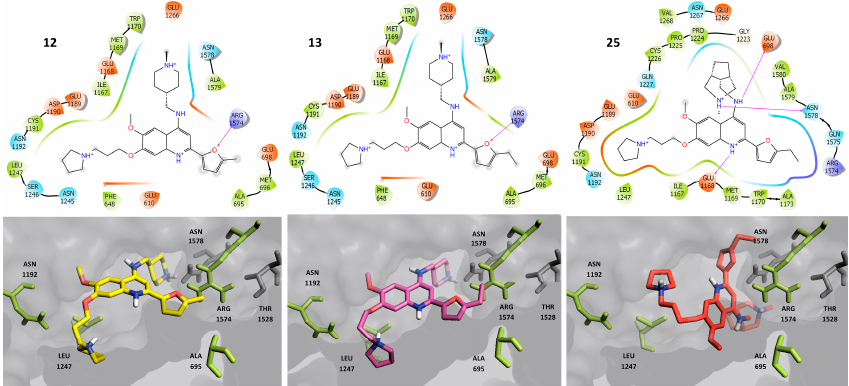
Figure 8. Predicted binding poses of dual compounds against DNMT1. Key amino acids proposed for the dual activity are highlighted in green.